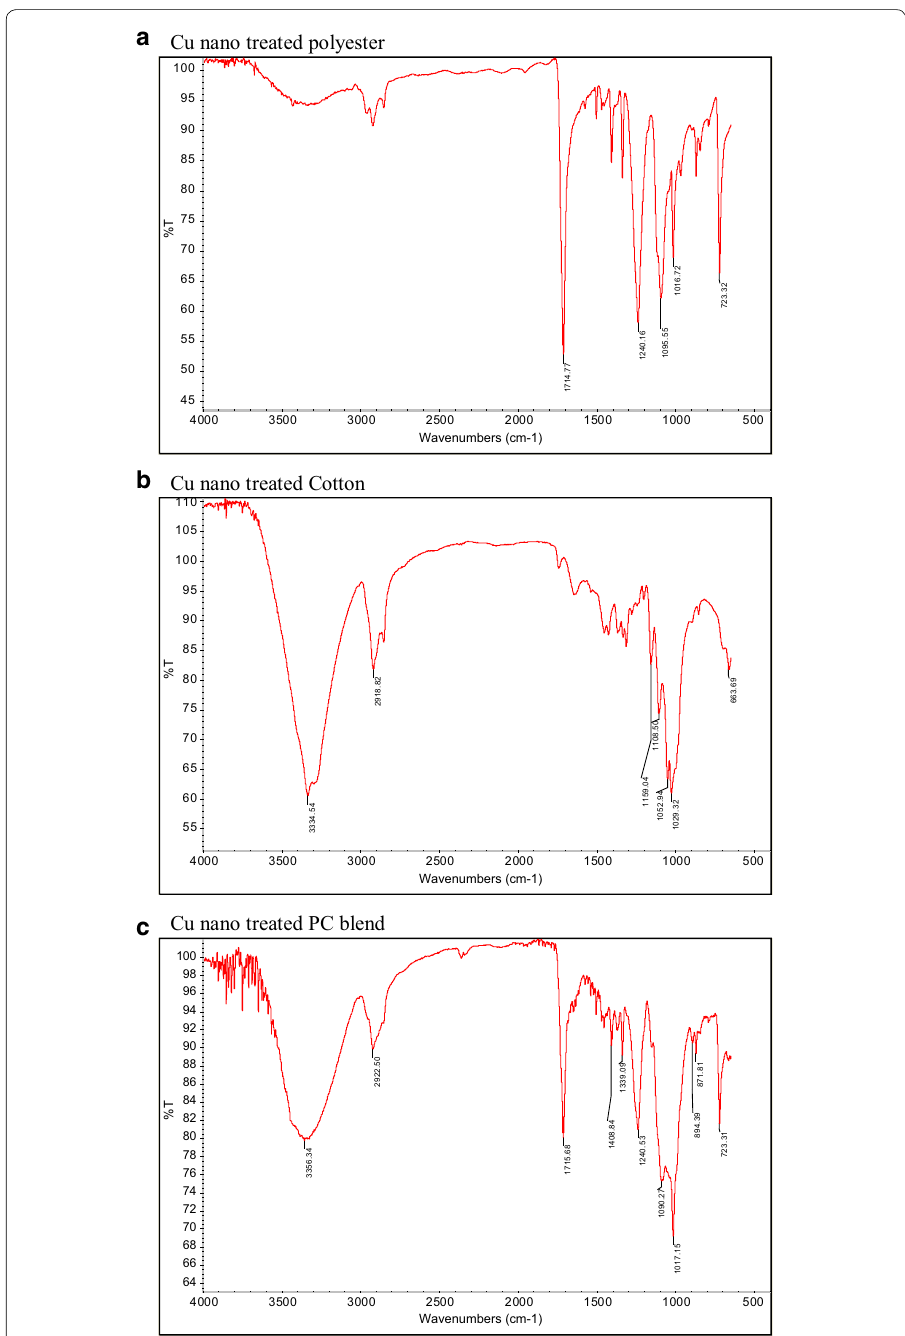
Fig. 6 a FT-IR spectrum of treated polyester fabric sample. b FT-IR spectrum of treated cotton fabric sample. c FT-IR spectrum of treated polyester-cotton fabric Elemental analysis of copper nano coated fabrics Elemental analysis of treated woven fabrics on SEM is in form of spectra as shown in Fig. 7a, b and c. Presence of copper was confirmed by the elemental analysis curve for individual fabric samples. The inserted data in corresponding figures is the overall per- centage of copper added as a result of the treatment given to the fabrics.